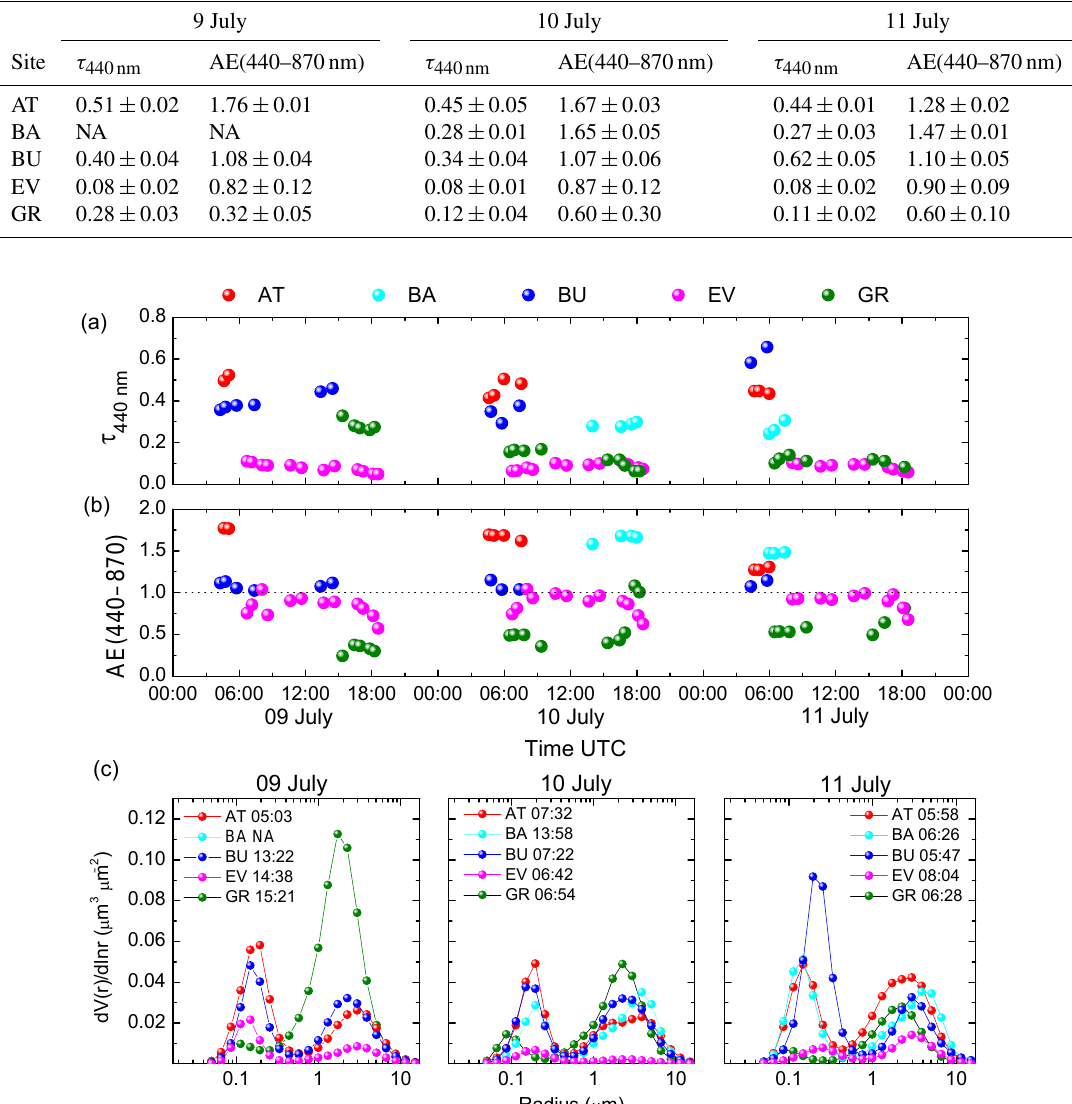
Figure 2. (a) AERONET level 1.5 retrieved τ 440nm and (b) AE(440–870nm) during the ChArMEx 2012 campaign at the five stations (see Table 1 for station descriptions). (c) AERONET version 2 level 1.5 size distributions retrieved for 9, 10, and 11 July. NA indicates no data